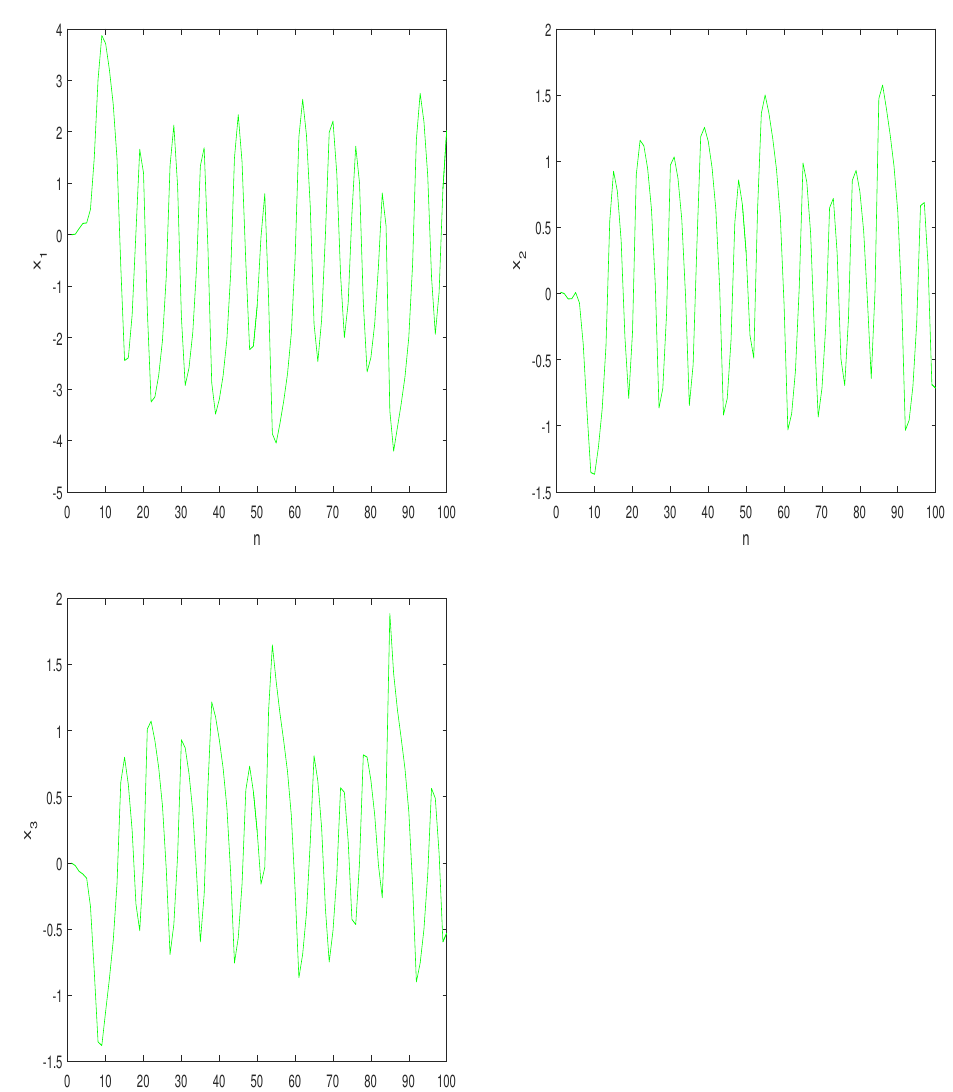
Figure 1. Time evolution of the states x 1 , x 2 and x 3 of the D.T.H.N.N with incommensurate fractional V.O